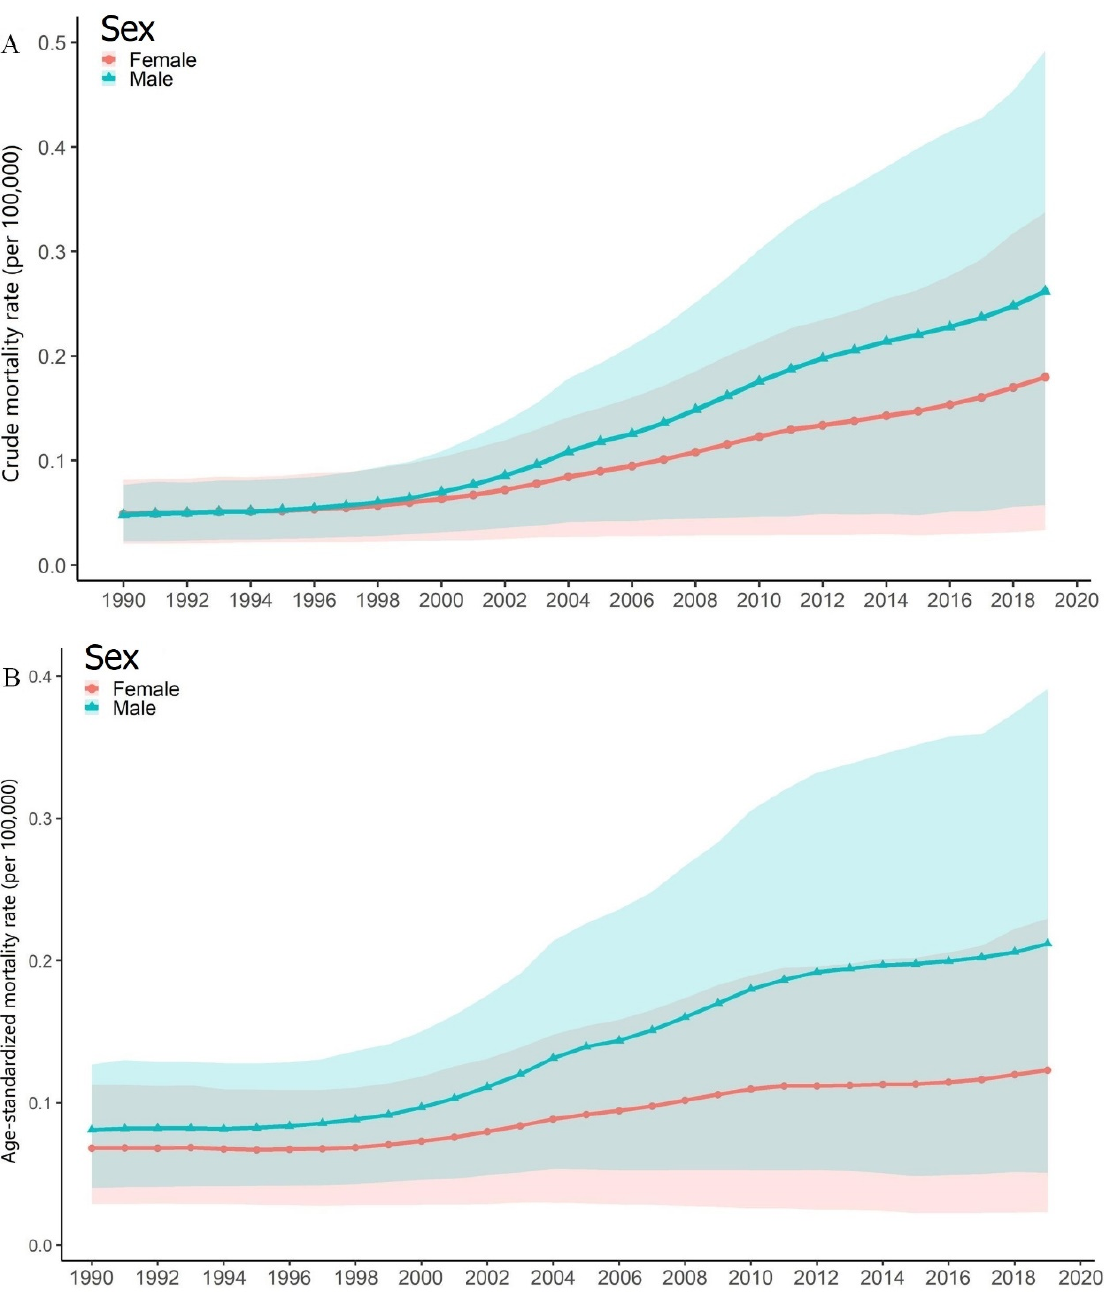
Figure 1. Crude mortality rates (CRMs) and age-standardized mortality rates (ASMRs) of CRC (per 100,000) from 1990 to 2019 and corresponding 95% confidence intervals (presented with shadows) attributable to high PM intake for both sexes in China. ( A ) CMRs for both sexes; ( B ) ASMRs for both